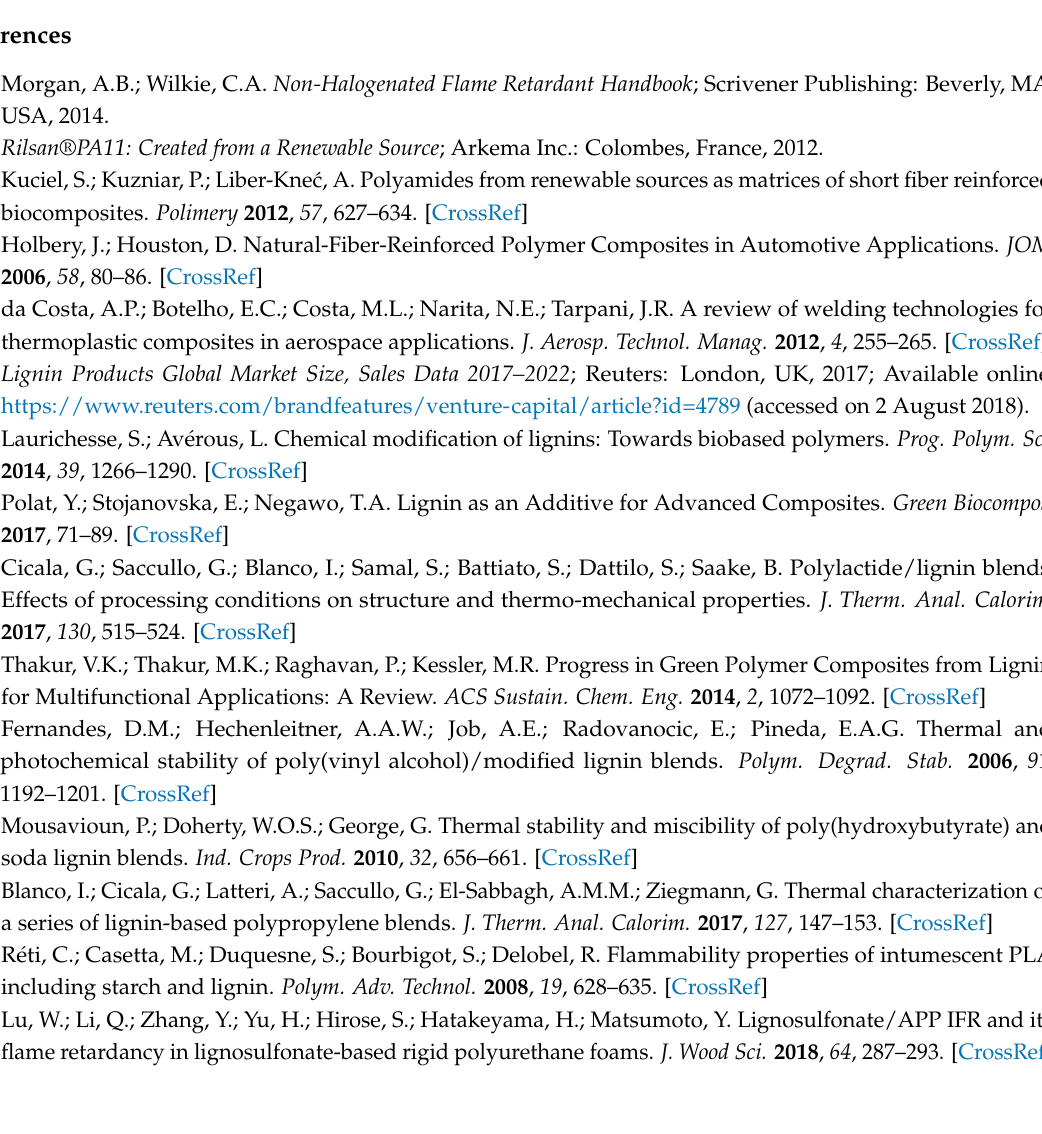
Figure S1: SEM images showing particle size distribution of pristine material, (a) ZnP, (b) AlP, (c) DL, (d) LL. Figure S2. TG curves of unfilled PA11 and neat materials in N2 (a) and air (b), Figure S3. HRR and THR curves of PA11 and the binary blends, (a) and (b) PA80-LL20, (c) and (d) PA80-DL20, (e) and (f) PA80-ZnP20, (g) and (h) PA80-AlP20 blends, Figure S4. CO and CO2 evolution during combustion for PA11 and the binary blends, (a) and (b) PA80-LL20, (c) and (d) PA80-ZnP20, (e) and (f) PA80-AlP20 blends. Table S1: Thermogravimetric data for PA11 and its blends in N2 and air. Table S2. UL94 vertical flame spread test data for PA11 and the binary blends, Table S3. Cone calorimetry data for PA11 and its binary